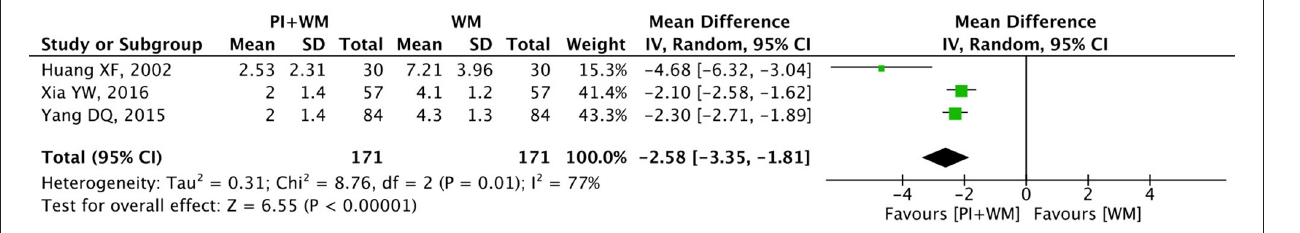
FIGURE 6 | Funnel plot on the frequency of angina attack.